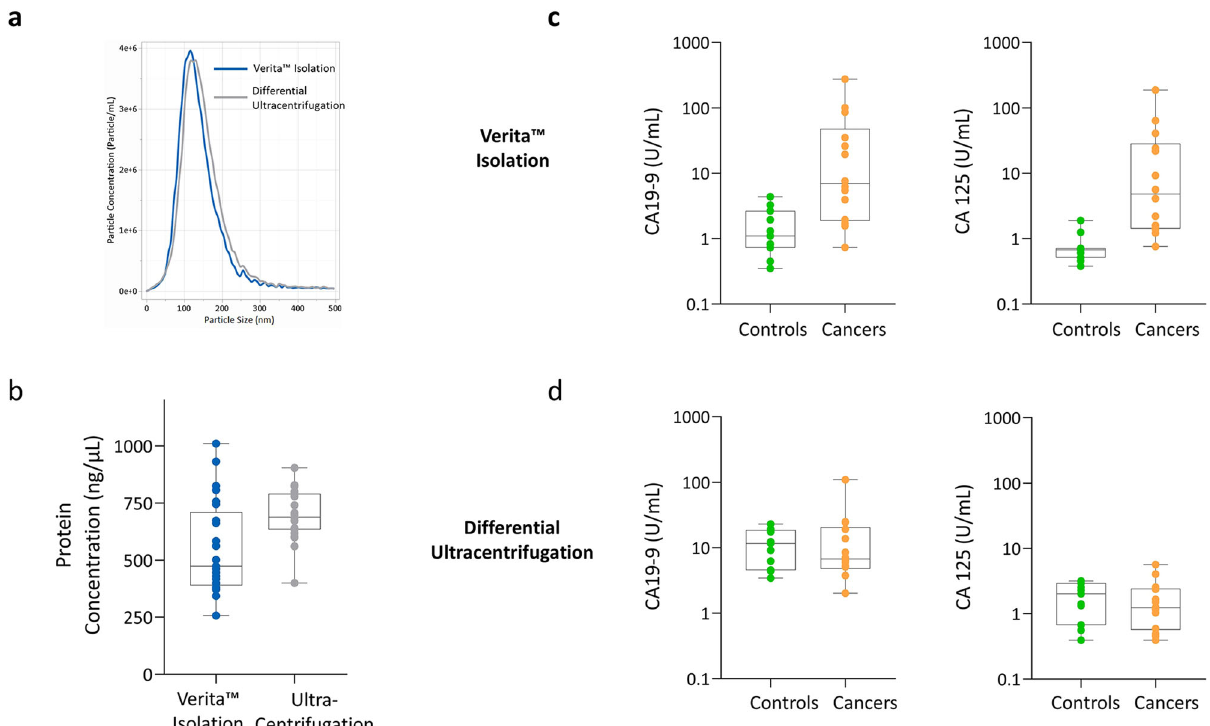
Fig. 3 Characterization of EVs isolated by either Verita ™ or differential ultracentrifugation. a Distribution of particle sizes as determined by nanoparticle tracking analysis. Blue line represents the particle distribution from Verita ™ isolation ( N = 25 subjects) while the gray line represents the isolation from differential ultracentrifugation ( N = 25 subjects). b Levels of residual contaminating total proteins based on Qubit ™ protein assay ( N = 25 subjects for each isolation methodology). The ability to differentiate cancer cases from controls based on biomarkers CA 19-9 and CA125 is shown for EVs isolated using the Verita ™ isolation in panel ( c ), and EVs isolated by differential ultracentrifugation in panel ( d ). In both ( c ), ( d ) panels, the N for Controls is 11 subjects, and the N for Cancers is 14